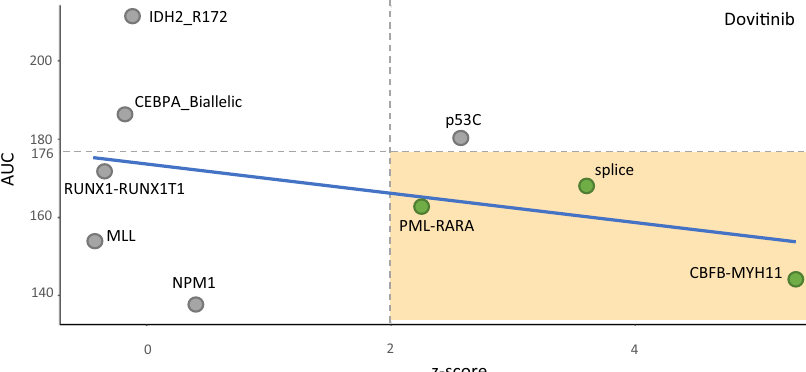
Fig. 4 AUC versus z -score for different AML molecular subtypes. Each point represents samples of an individual subtype group. The y-axis is the median value of drug response (AUC) of each subtype group. The z -score (x-axis) is a statistic of network enrichment analysis (NEA), which is used to assess the interaction between the subtype-speci fi c genes and the drug-target genes in the functional gene network. A higher z - score indicates a stronger interaction than expected in a random permutation of the network. The blue line is the linear regression line. The yellow rectangle suggests some interesting subtypes, which respond to the drug potentially via the functional interaction between the subtype-speci fi c and the drug-target